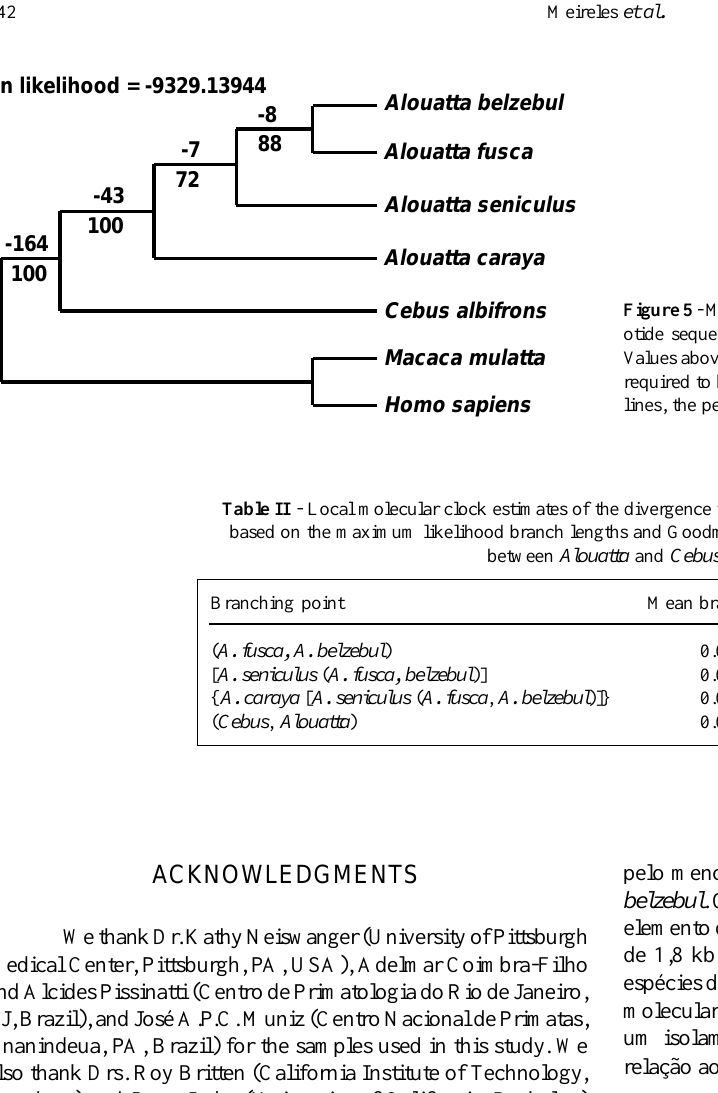
moleculares é congruente com as de estudos morfológicos, com um isolamento claro do grupo monoespecífico A. caraya em relação ao grupo A. seniculus .